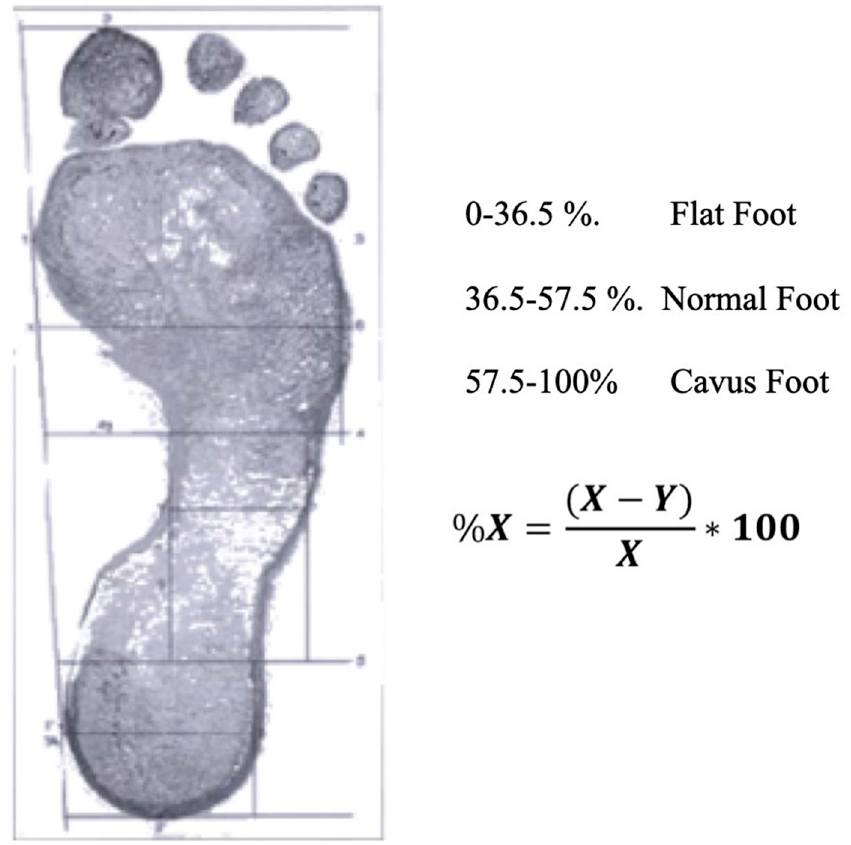
Figure 1. Classification of foot type according to the percentage of X calculation .